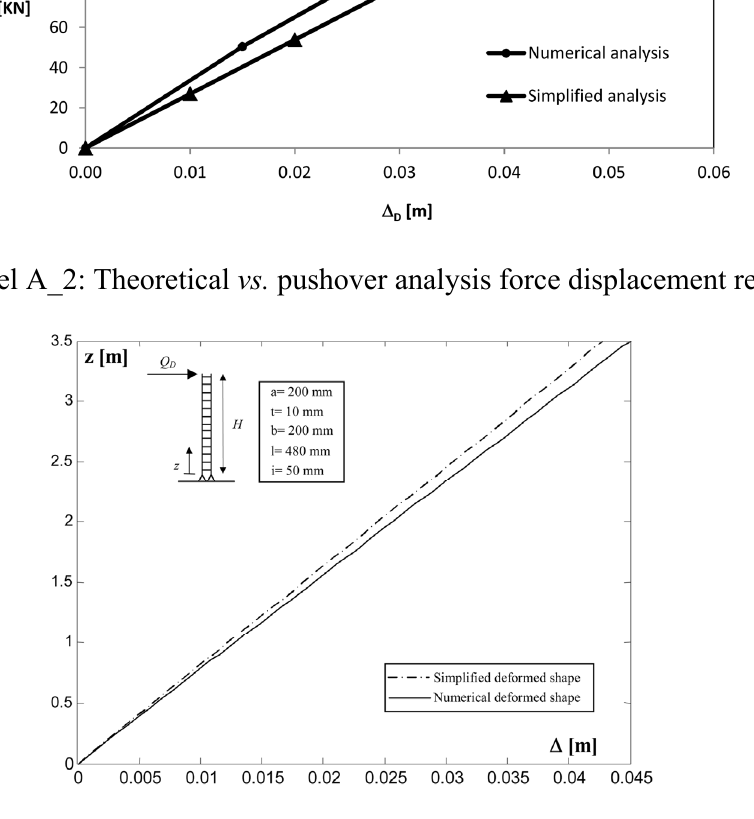
Figure 9. Model A_2: Simplified vs. numerical deformed